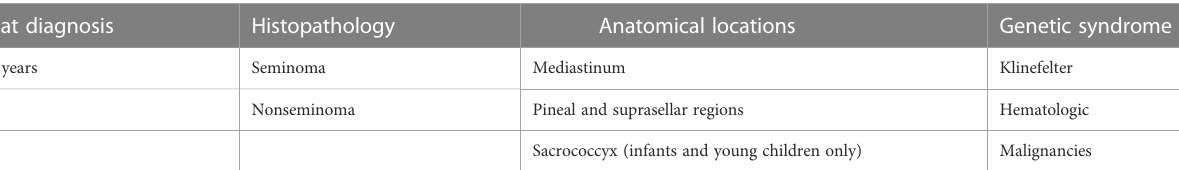
TABLE 1 Clinical features of EGCTs (1, 7,